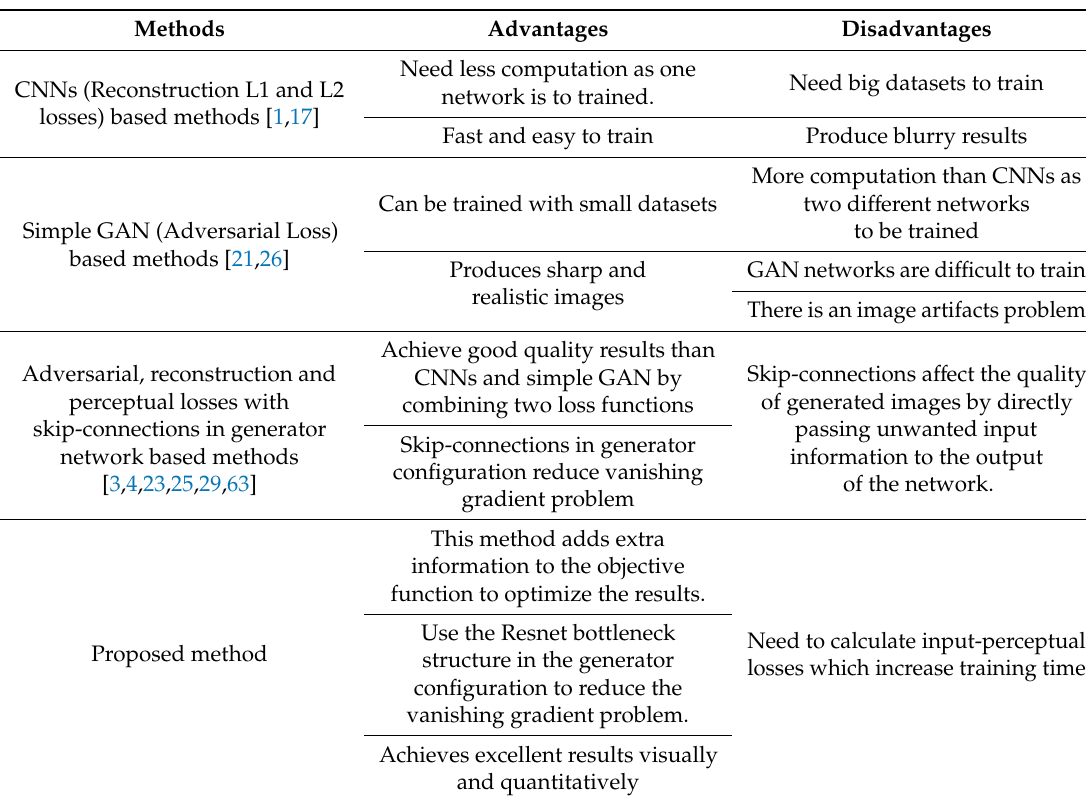
Table 1. Comparison between state-of-the-art and proposed